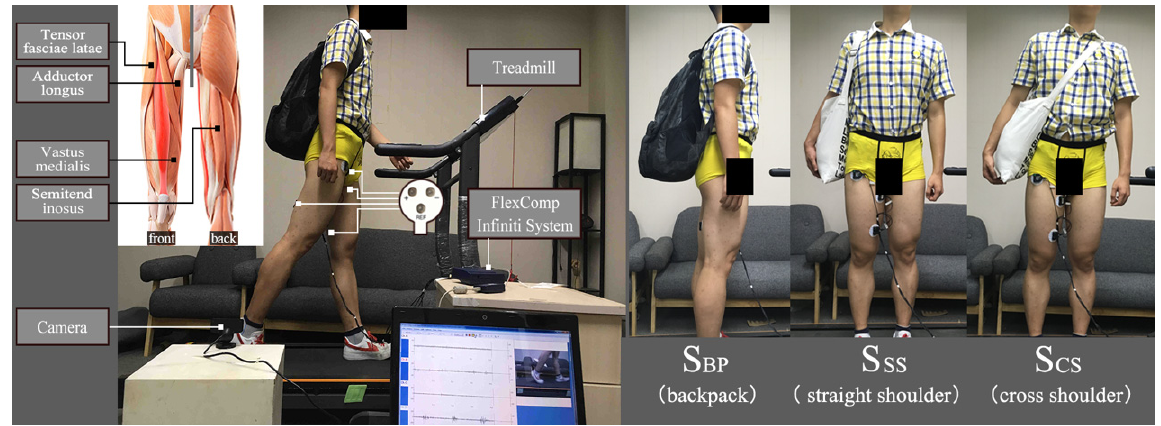
Figure 1. The experimental equipment and connection, the placement of the electrodes, and load styles (S BP = backpack, S CS = cross shoulder, and S SS = straight shoulder).